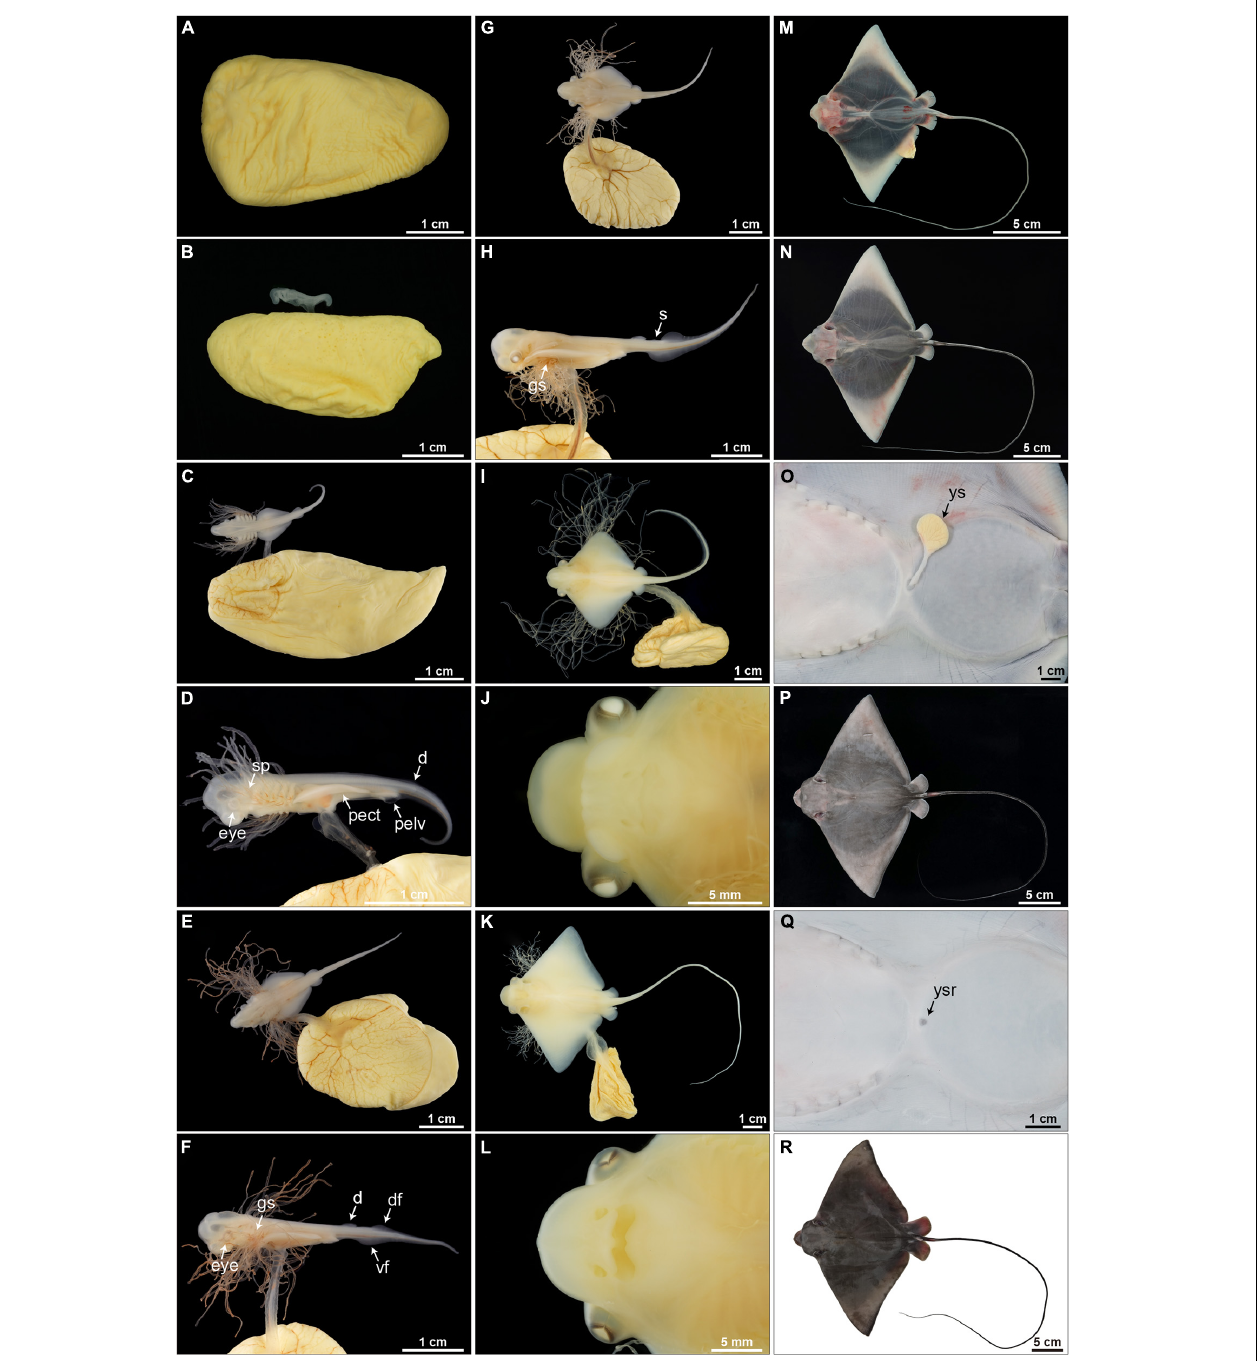
FIGURE 9 | Embryonic development (stages 1–11) of Aetobatus narutobiei . (A) Stage 1: The egg is within an egg case and without a macroscopic embryo. (B) Stage 2: Macroscopic embryos on uterine eggs within an egg case (11.72 mm TL). (C,D) Stage 3: The pectoral fins within the posterior margins of the gills (6.56 mm DW). (E,F) Stage 4: The pectoral fins beyond the posterior margin of the gills but within the anterior margins of the gills (10.79 mm DW). (G,H) Stage 5: The pectoral fins beyond the gills but within the posterior margin of the eyes (16.10 mm DW). (I,J) Stage 6: The pectoral fins are fused forming the disc, the cephalic lobes are developing (36.09 mm DW). (K,L) Stage 7: The cephalic lobes are formed completely, the yolk sac and gill filaments persist (75.04 mm DW). (M) Stage 8: Gill filaments are resorbed but the yolk sac remains, muscle tissue in the center of the disc appears black but the disc margins remain translucent (132.80 mm DW). (N,O) Stage 9: The yolk sac is diminished and the body is free of pigmentation (116.35 mm DW). (P,Q) Stage 10: The yolk sac is resorbed and the dorsal surface is begins to turn gray–black (241.00 mm DW). (R) Stage 11: Body pigmentation is present (312.00 mm DW). d, dorsal fin; df, dorsal fold; gs, gill slit; pect, pectoral fin; pelv, pelvic fin; s, spine; vf, ventral fold; ys, external yolk sac; ysr, yolk sac